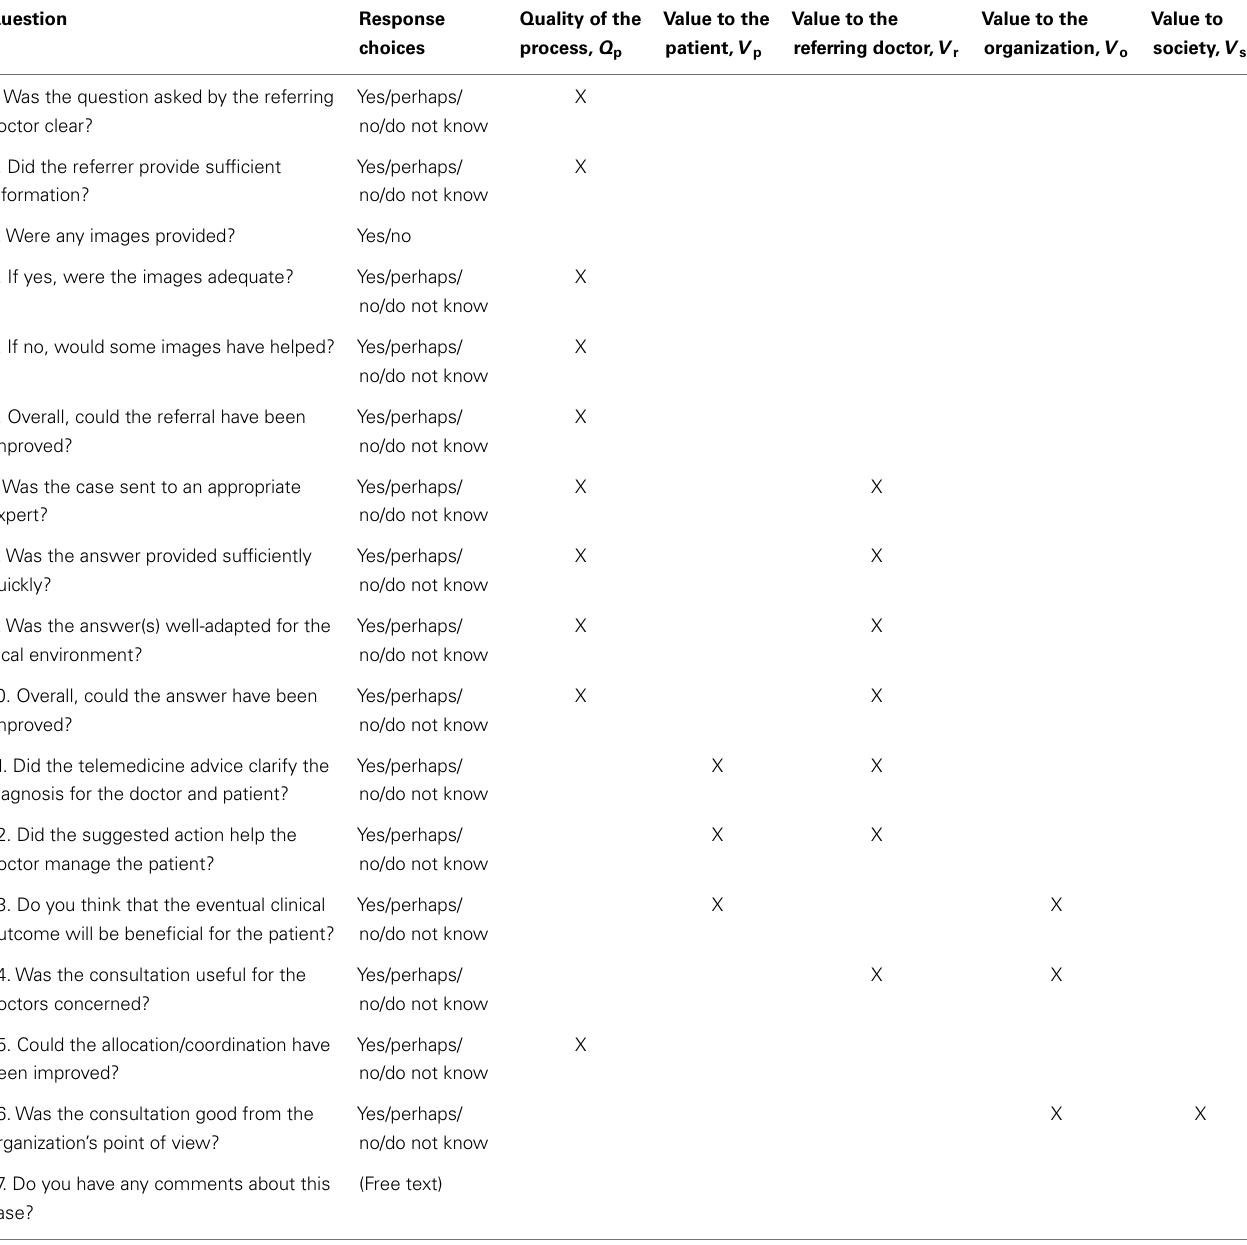
Table 2 | Quality-assessment questions